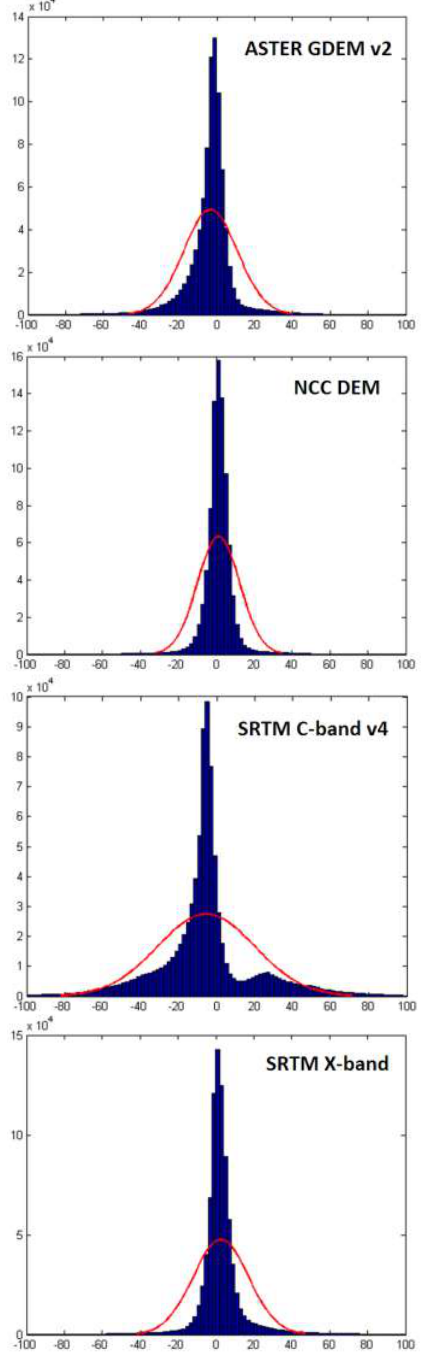
Figure 5: Histogram of differences between TDX DEM products and NCC